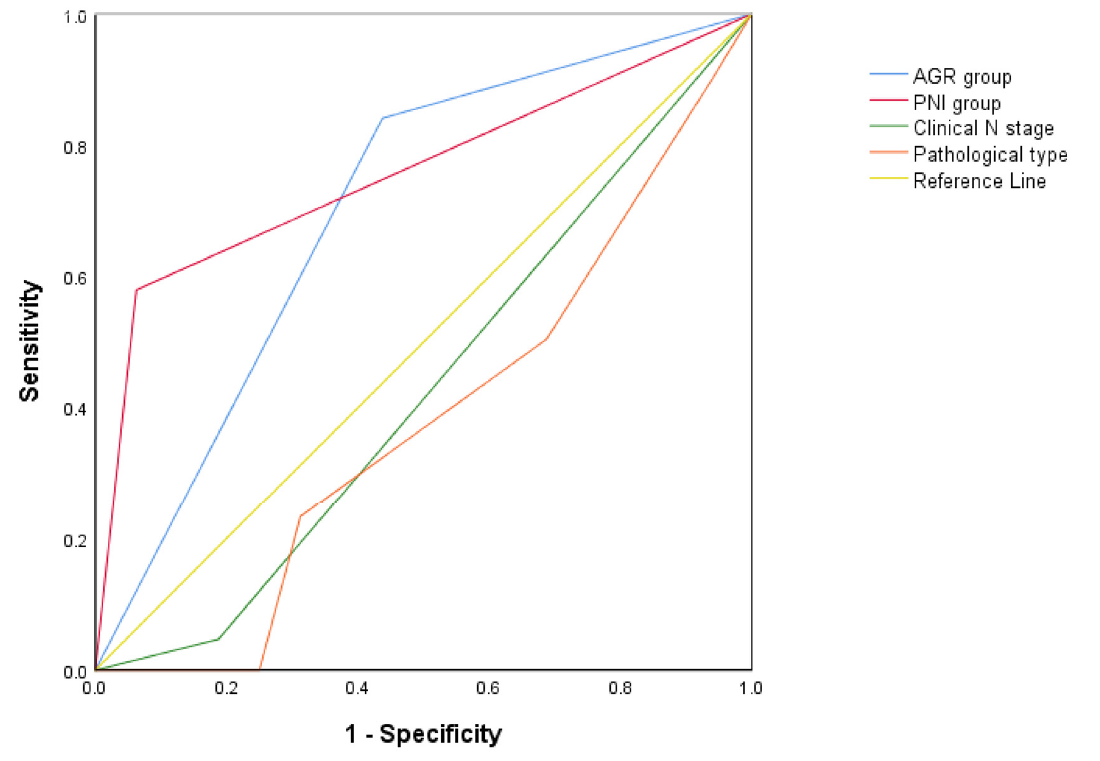
Figure 3. Receiver operating characteristic curves for all the independent factors of multivariable analysis.